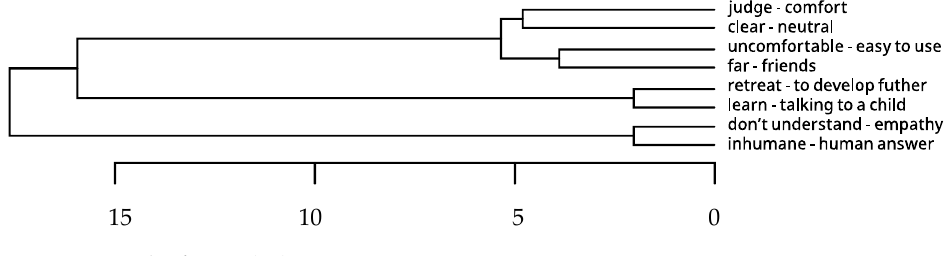
Figure 7. Result of HCA (P1).